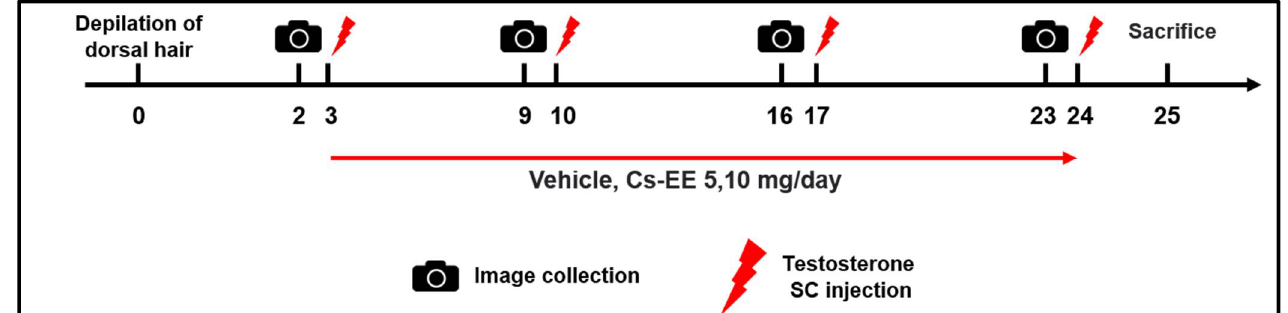
Figure 7. General scheme of the in vivo experiment. Shaved mice were given a subcutaneous injection of testosterone (40 μg/kg) four times over the course of three weeks, and Cs-EE (0–10 mg/kg) was applied to the skin on the backs of the mice once a day for three weeks.